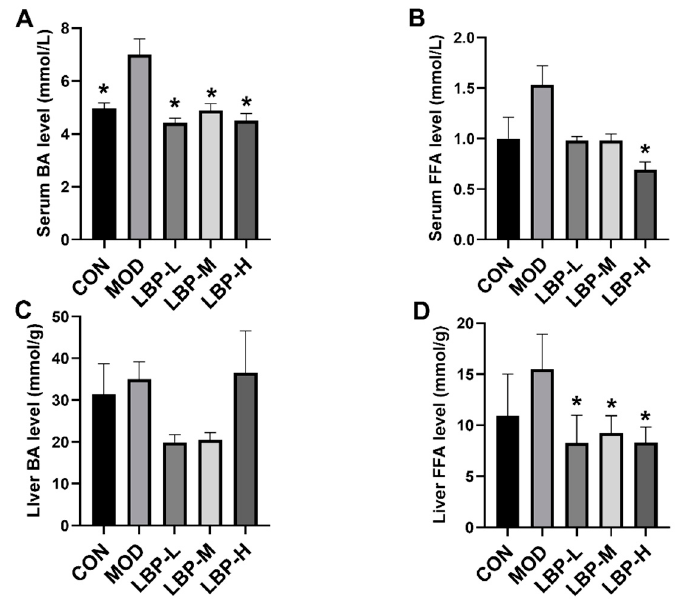
Figure 2. The effects of LBP feeding on BA, FFA in both serum and liver tissues in high-fat diet induced obese mice. ( A ) serum BA; ( B ) serum FFA; ( C ) liver BA; ( D ) Liver FFA. LBP, Lycium barbarum polysaccharide; BA, bile acid; FFA, free fatty acid. *, p < 0.05, compared with the model group (MOD). Sample size for each group = 8.